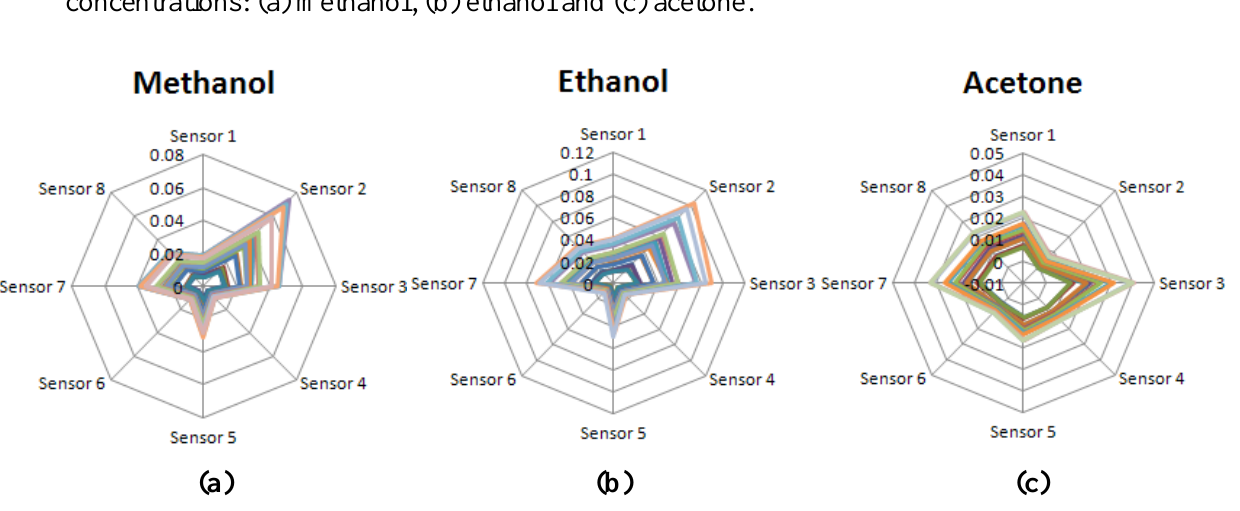
Figure 3. The normalized odor patterns of three vaporized solvents with different concentrations: (a) methanol, (b) ethanol and (c)